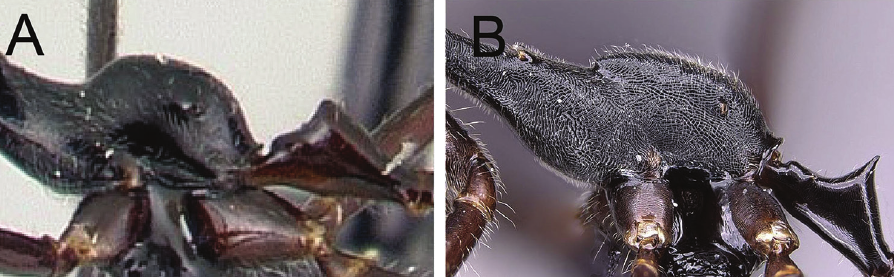
Figure 8. Lateral view of propodeum and petiole in minor workers of A Camponotus karaha (CASENT0067555), and B Camponotus jodina